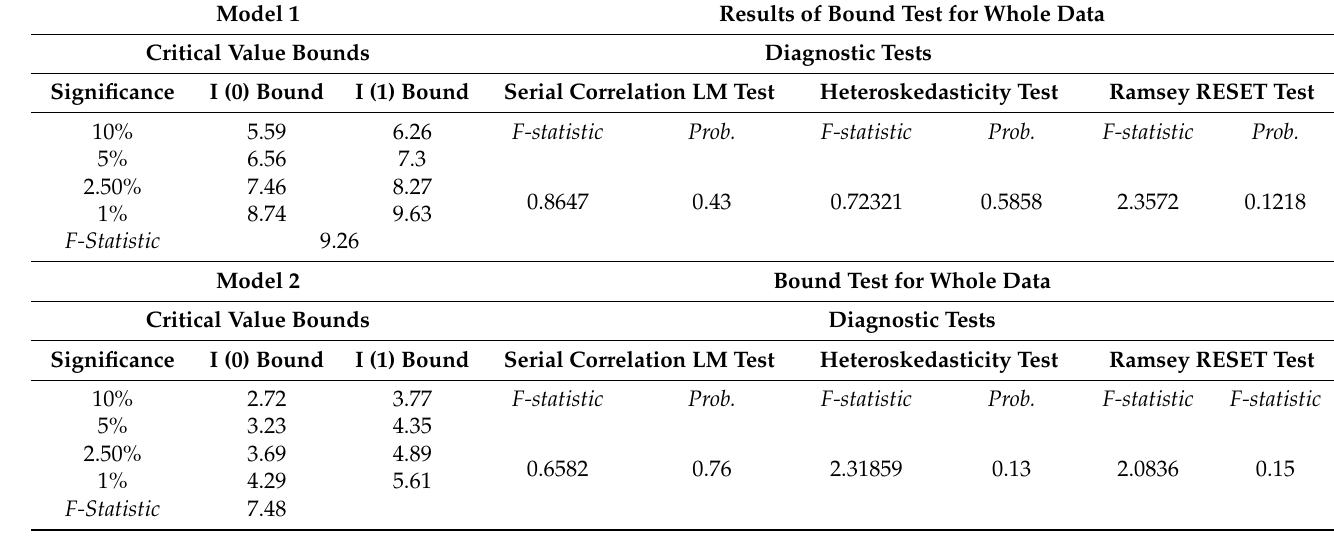
Table 4. Results of bound test for whole